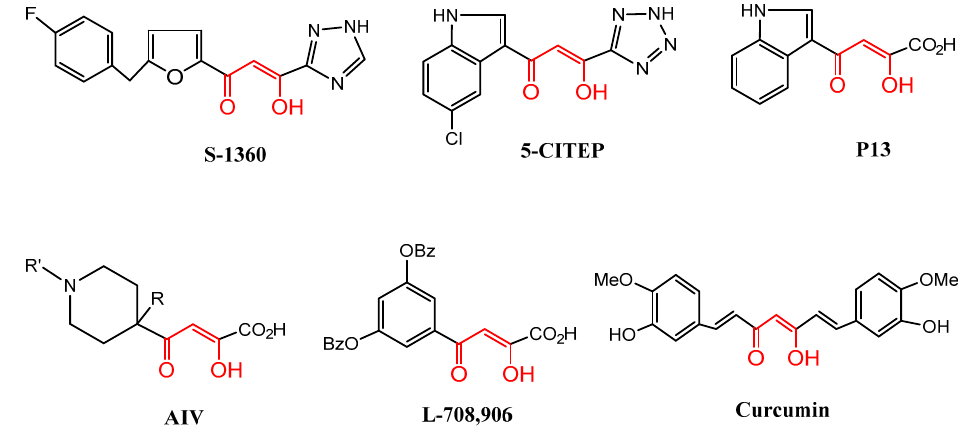
Figure 1. Representative drugs containing keto-enol functionality.